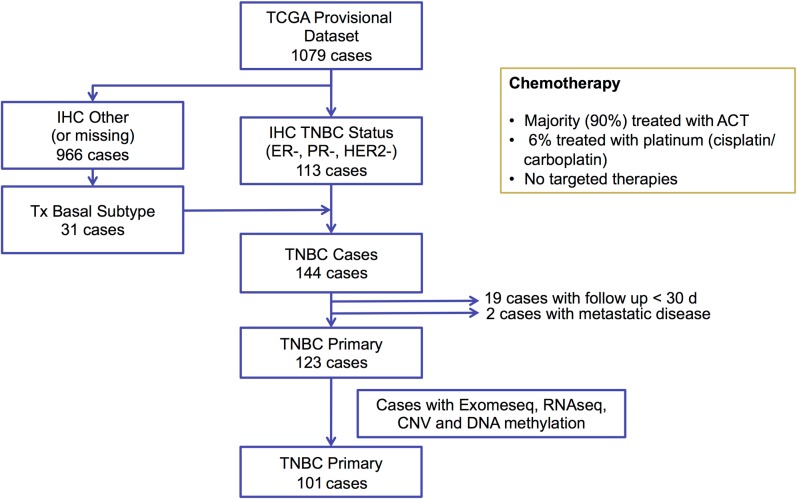
Diagram for selecting triple negative breast cancer samples from the TCGA breast cancer dataset.ACT, anthracycline/taxane; CNV, copy number variation; ER, estrogen receptor; Exomeseq; exome sequencing; IHC, immunohistochemistry; PR, progesterone receptor; RNAseq, RNA sequencing; TCGA, The Cancer Genome Atlas; TNBC, triple negative breast cancer.